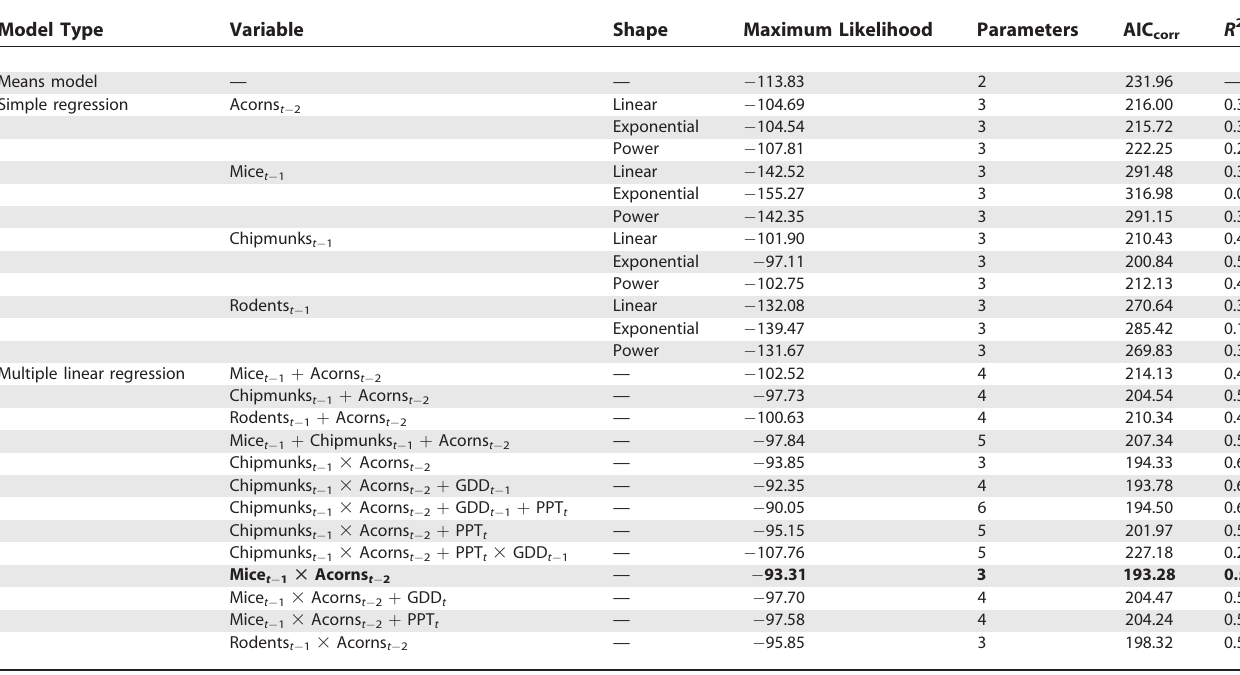
Table 6. Model Comparison Statistics for Independent Variables Potentially Influencing the DIN Based on the Subset of Plot Years for Which All Independent Variables Were Estimated (42 Plot Years)